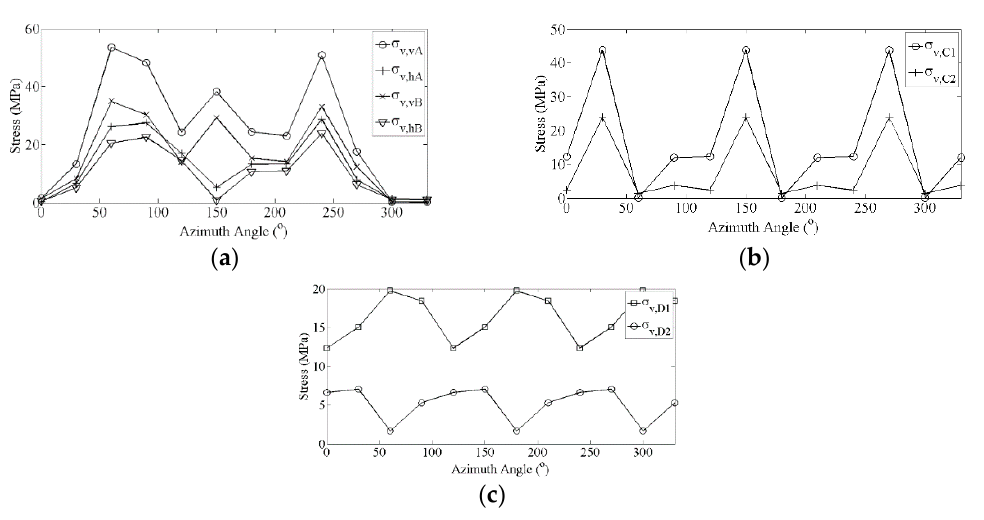
Figure 15. Von Mises stresses at fatigue-critical locations: ( a ) At A1, A2, B1, and B2; ( b ) At C1 and C2; ( c ) At D1 and D2.